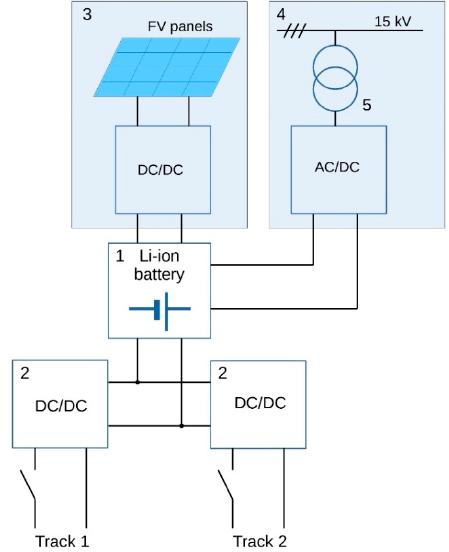
Figure 2. A single supplying module with two DC/CD converters, dedicated to double track line. 1—lithium-ion battery pack, 2—DC/DC converters dedicated to being connected to separate OCS sections, 3—part of the module dedicated to drawing the energy from solar panel (the part is op- tional), 4—connection to medium voltage supplying line (part is